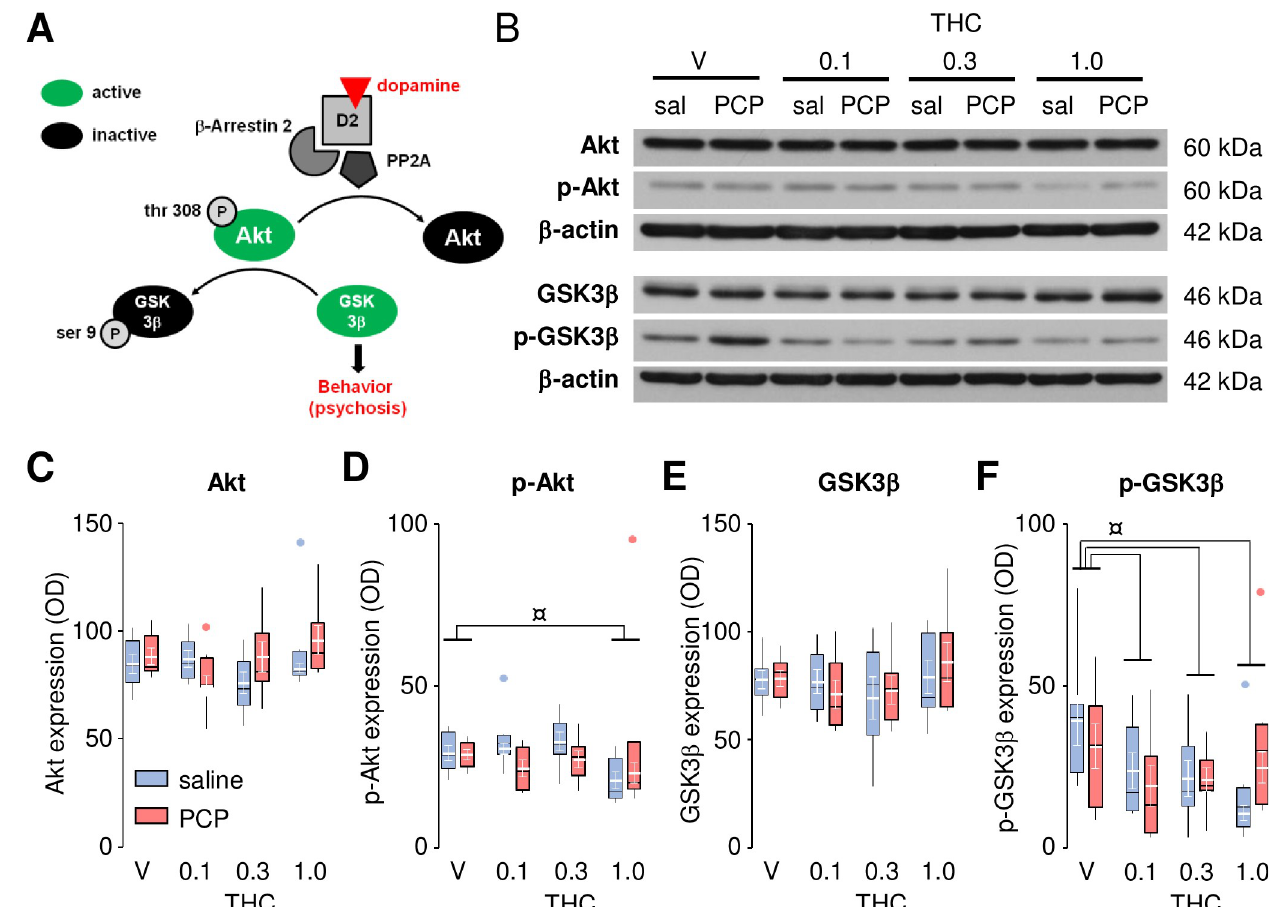
Fig 3. Effects of THC (0.1–1.0 mg/kg) in saline- and PCP- treated rats on the Akt-GSK3 β pathway. Scheme of the Akt/GSK-3 β signaling pathway and the sequence of events leading to the expression of dopamine-associated behaviors (based on [45]; A ). Representative western blot data ( B ) showing Akt expression (normalized to β -actin; C ) and phosphorylation (p-Akt at thr 308; normalized to Akt; D ), as well as GSK3 β expression (normalized to β -actin; E ) and phosphorylation (p-GSK3 β at ser 9; normalized to GSK3 β ; F ) in saline- (sal) and PCP-treated rats. The raw data for this figure are reported in the supplemental file (S1 Raw data) and are summarized here as boxplots computed using Carling’s modification [42]; outliers are depicted as blue (saline) or red (PCP) circles. Values (in white) are expressed as mean ± S.E.M. (n = 6–7 per group). ¤ P < 0.05 (Newman-Keuls post-hoc test).